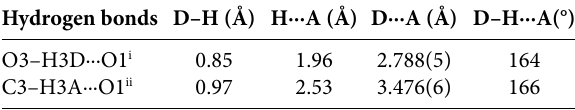
Table 3. Geometrical parameters for hydrogen bonds for 1 Table 4. Inhibition of rat brain MAO-B for HL , complexes 1–3 ,